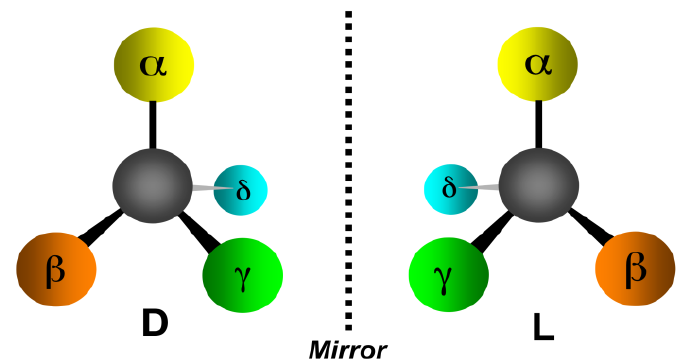
Figure 1. Example of D- and L-enantiomers.